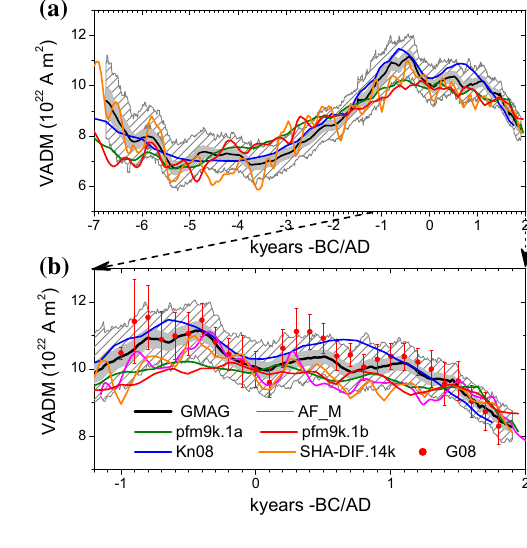
Fig. 5 Geomagnetic field intensity over millennia: VADM reconstructions over past 9000 years ( a ), with a zoom for the last 3200 years ( b ). Notations are: GMAG.9k (Usoskin et al. 2016a) with 1 σ ( gray shading ) and the full range variability (hatching); AF_M (Licht et al. 2013); G08 (Genevey et al. 2008); pfm9k.1b and pfm9k.1a (Nilsson et al. 2014); Kn08 (Knudsen et al. 2008); and SHA-DIF.14k (Pavón-Carrasco et al. 2014). Modified after (Usoskin et al.